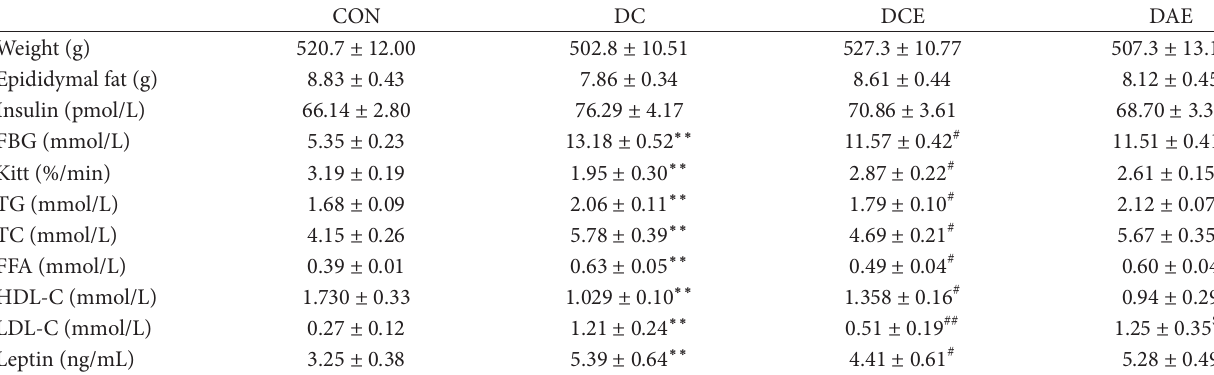
Table 1: Body weight and biochemical parameters of different